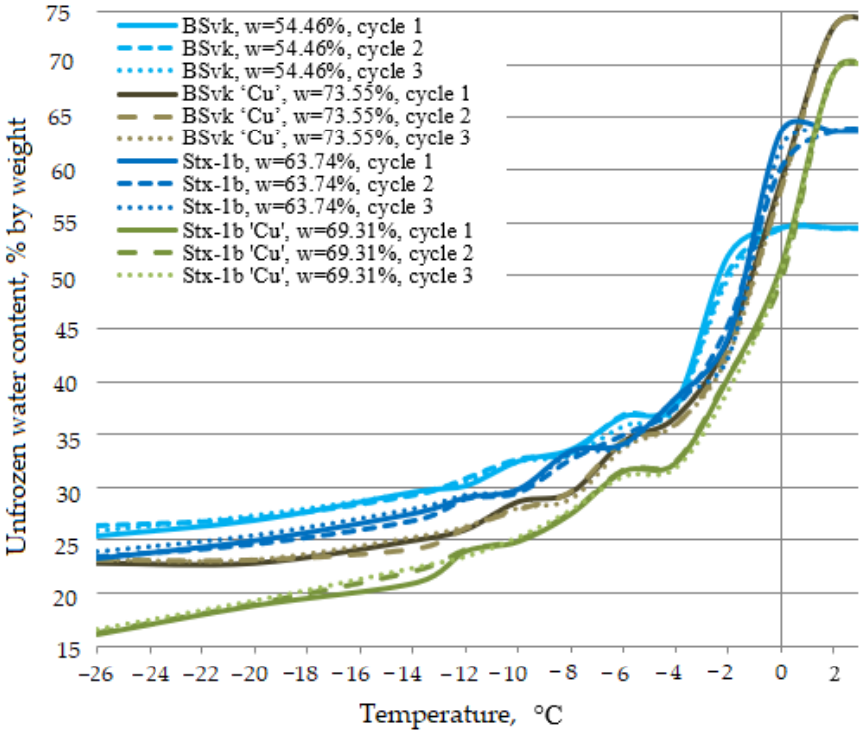
Figure 3. The unfrozen water content vs. temperature obtained in the thawing 1 – 3 cycles for the BSvk (Jelšov ý potok, Slovakia) and Stx-1b (Texas) bentonites before and after replacement with the ‘ Cu ’ ions for samples with different total water contents.